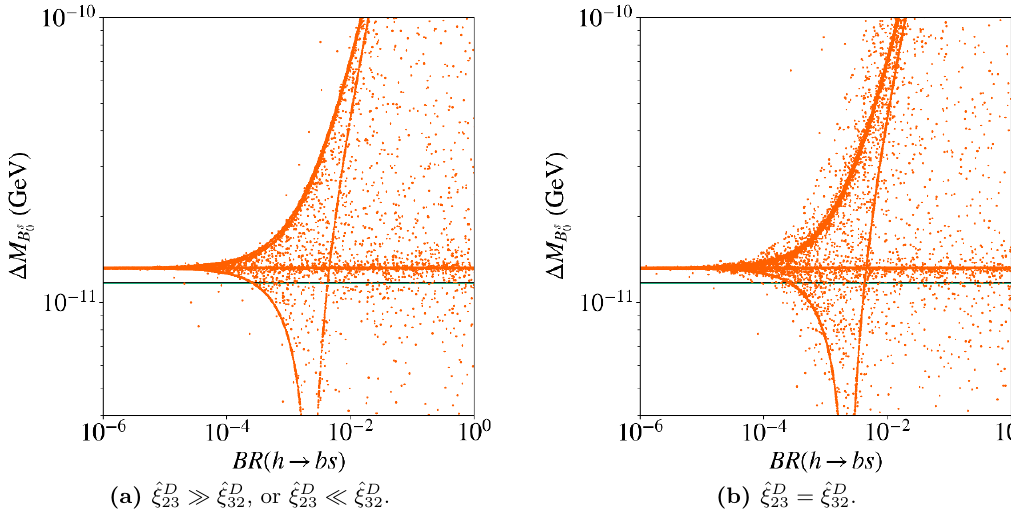
Figure 6 . Mass splitting (cid:1) M B , stemming from the SM and the 2HDM at tree-level, versus s BR( h ! bs ). We set m H = m A = 2000 GeV and s (cid:12) (cid:0) (cid:11) = 0 : 9. The horizontal line shows the observed value (the corresponding error is smaller than the width of the line itself). We see lower values of BR( h ! bs ) being more accessible for the case ^ (cid:24) D = ^ (cid:24) D 23 32